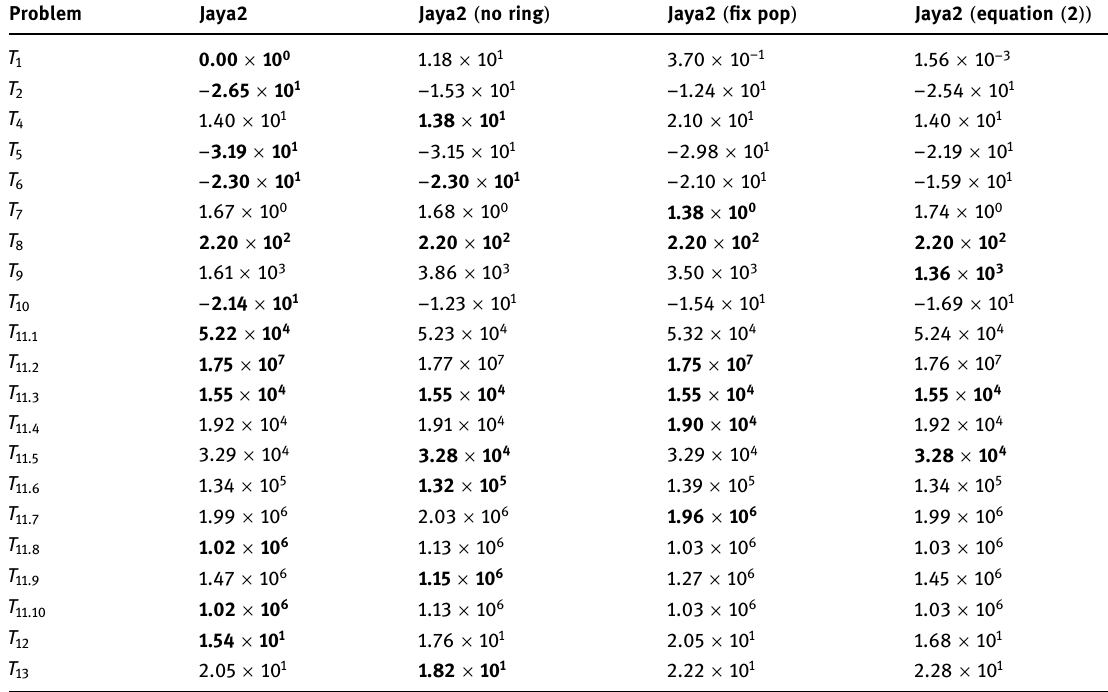
The boldface indicates the lowest median function value per